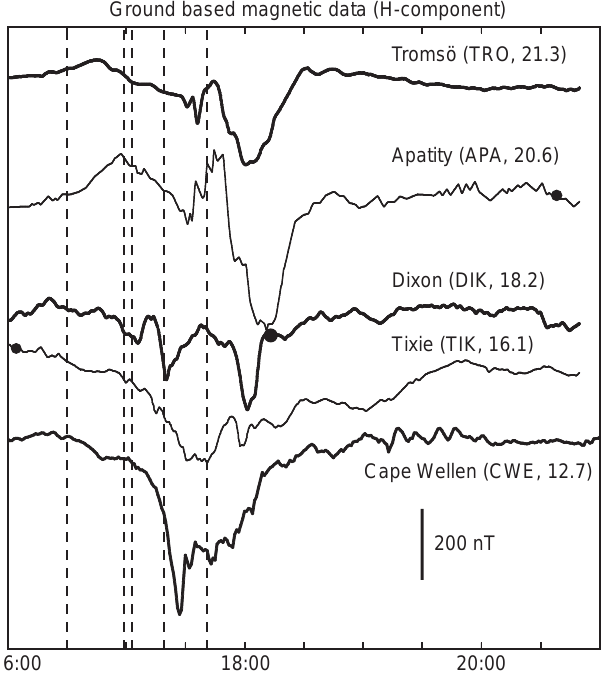
Fig. 2. H -component of magnetic field variations, registered by ground-based magnetometers in Tromsø, Apatity, Dixon, Tixie Bay and Cape Wellen on February 9, 1991. The growth phase onset and the four intensifications seen by CRRES and discussed in the text are marked as dashed vertical